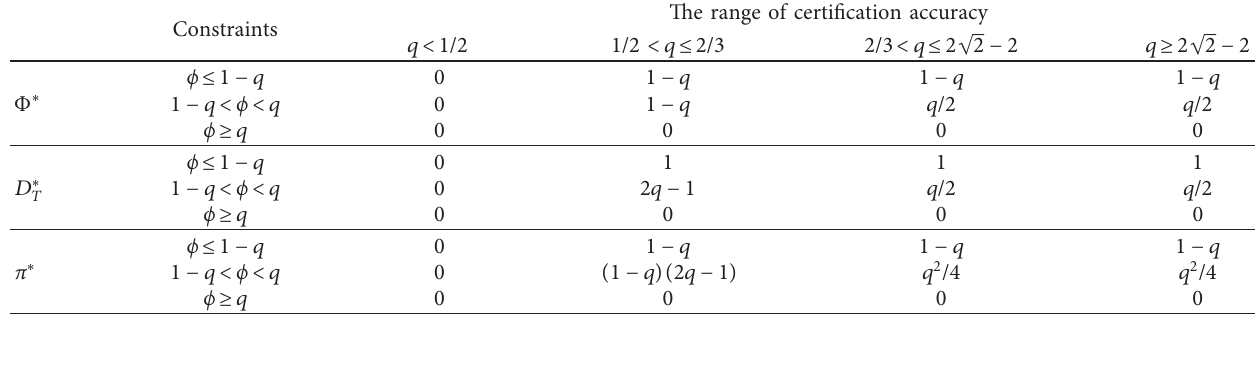
Table 3: The local optimal application fee, total market demand, and profits under different levels of certification accuracy.